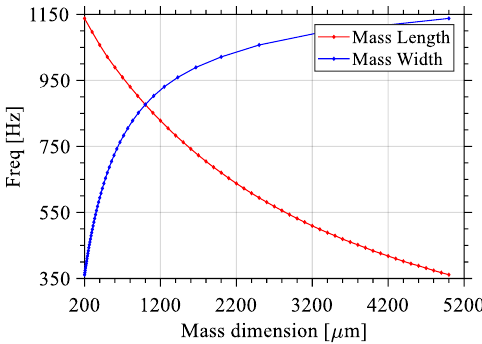
Figure 8. Effects of varying the length or the width of a constant-area (1 mm 2 ) mass on the value of the first Eigen frequency of the structure.